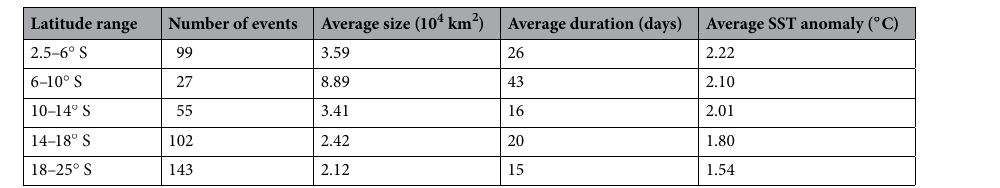
Table 1. Characteristics of MHWs in the coastal domain from 1982 to